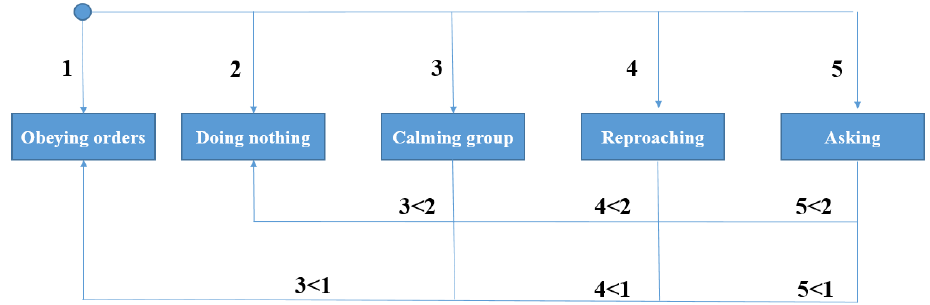
Figure A2. Situation 2—Abandonment. Note. 1 = execution; 2 = doing nothing; 3 and 5 = communi- cation; 4 = giving orders.